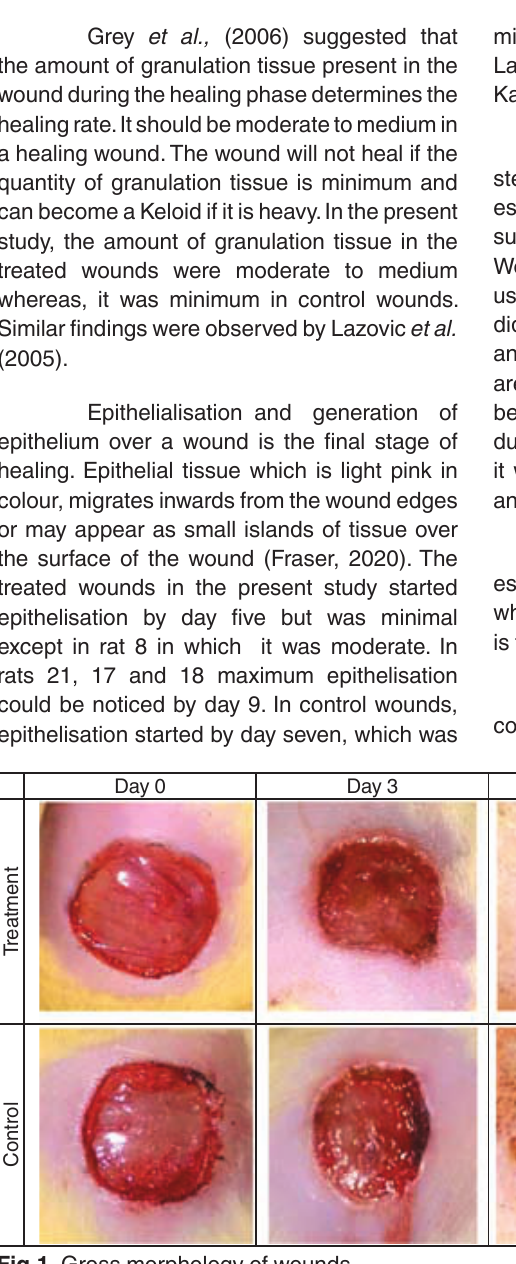
Fig.1. Gross morphology of table 1 . Wound Surface area (cm 2 ) n= 10